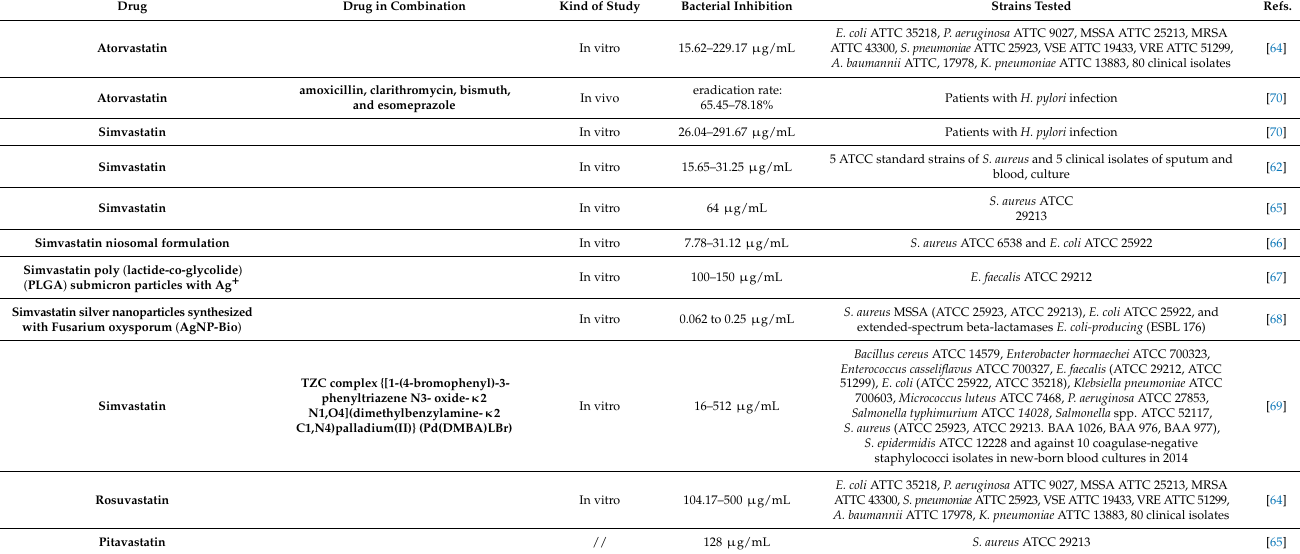
Table 3. Statins with antimicrobial